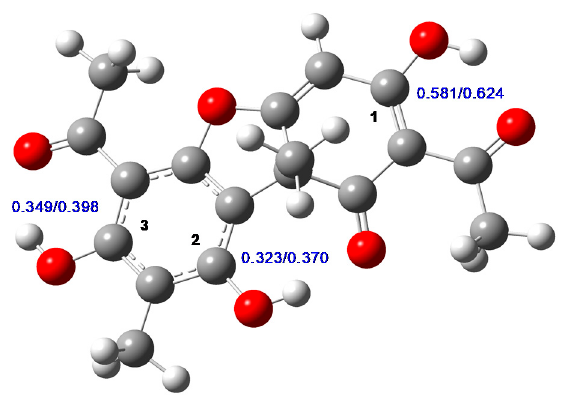
Figure 1. Structure of the usnic acid (most stable tautomer) from AM1 geometry optimization. The carbons bonded to hydroxyl groups, and the respective ESP (electrostatic potential) charges (B3LYP/6-31g+(d,p)) of each (ideal gas/water) are indicated.